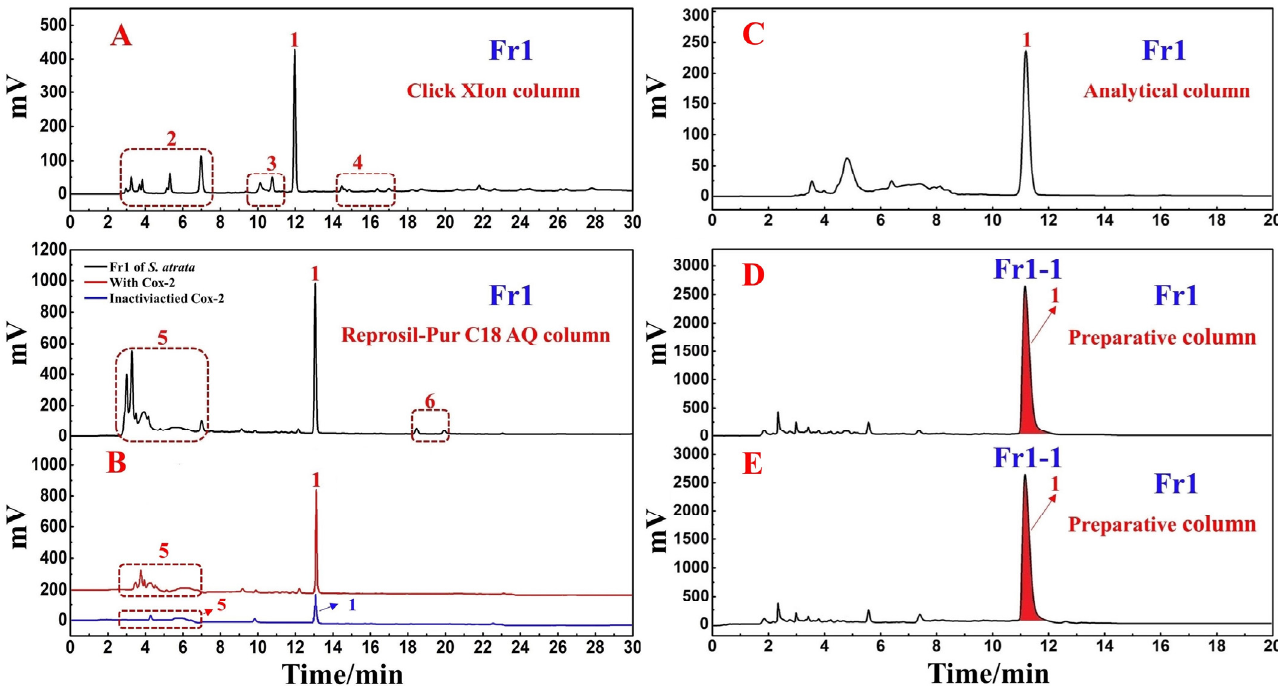
Figure 2. The chromatogram derived from the Click XIon analytical column ( A ) An affinity ultrafiltration-HPLC chromatogram for potential COX-2 ligands present in S. atrata target fraction Fr1 ( B ). The black, red, and blue lines, respectively, correspond to the HPLC chromatograms of S. atrata target fraction Fr1 without COX-2, with activated COX-2, and with inactivated COX-2. The analytical ( C ) and preparative ( D , E ) chromatograms of Fr1 on the ReproSil-Pur C18 AQ column. Number 1 represents the target main component in Fr1, while red dashed boxes 2, 3, 4, 5, and 6 highlight the impurities present in Fr1. Conditions: mobile phase A: 0.2% v/v formic acid in water, B: ACN; gra-